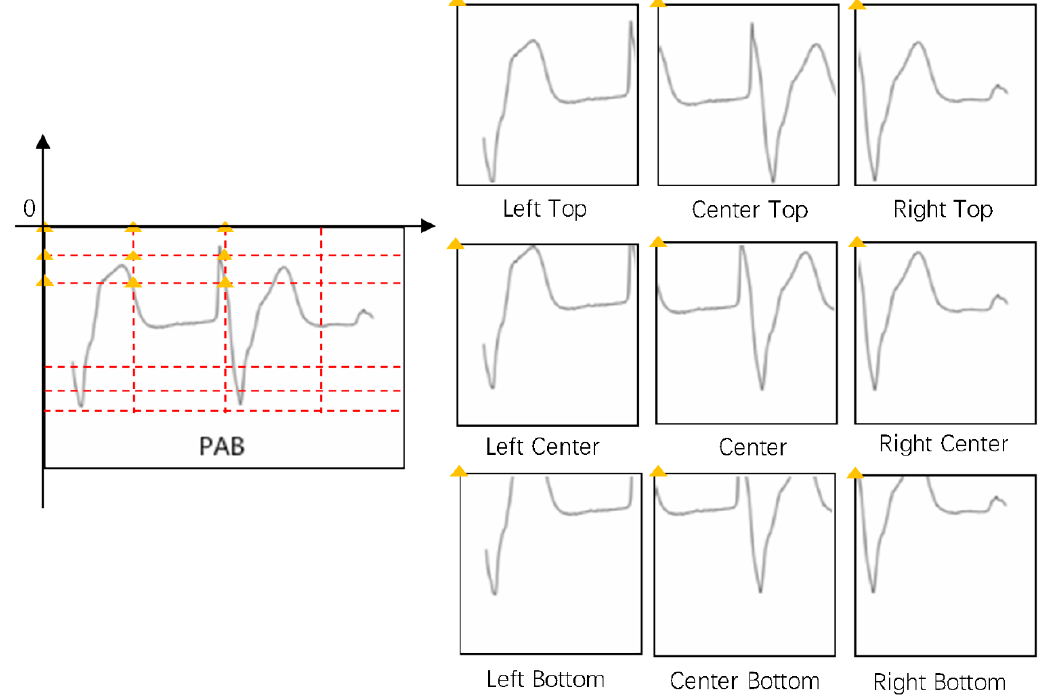
Figure 2. Original paced beat (PAB) image and nine cropped images.